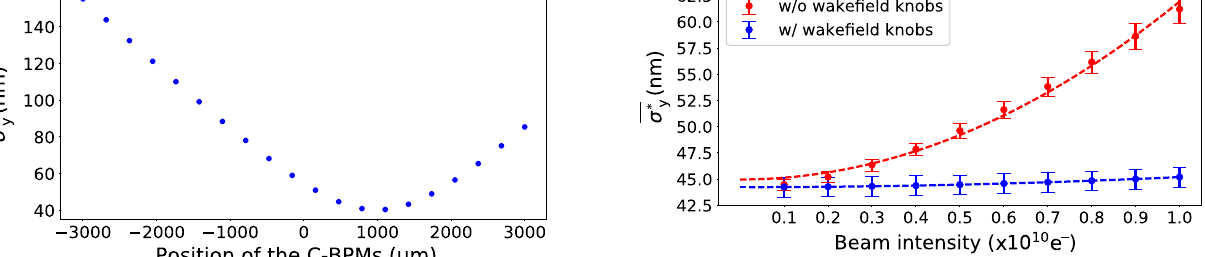
FIG. 13. Average vertical IP beam size ( σ (cid:1) y ) vs the position of the C-BPMs, for one machine at 1 . 0 × 10 10 e − .